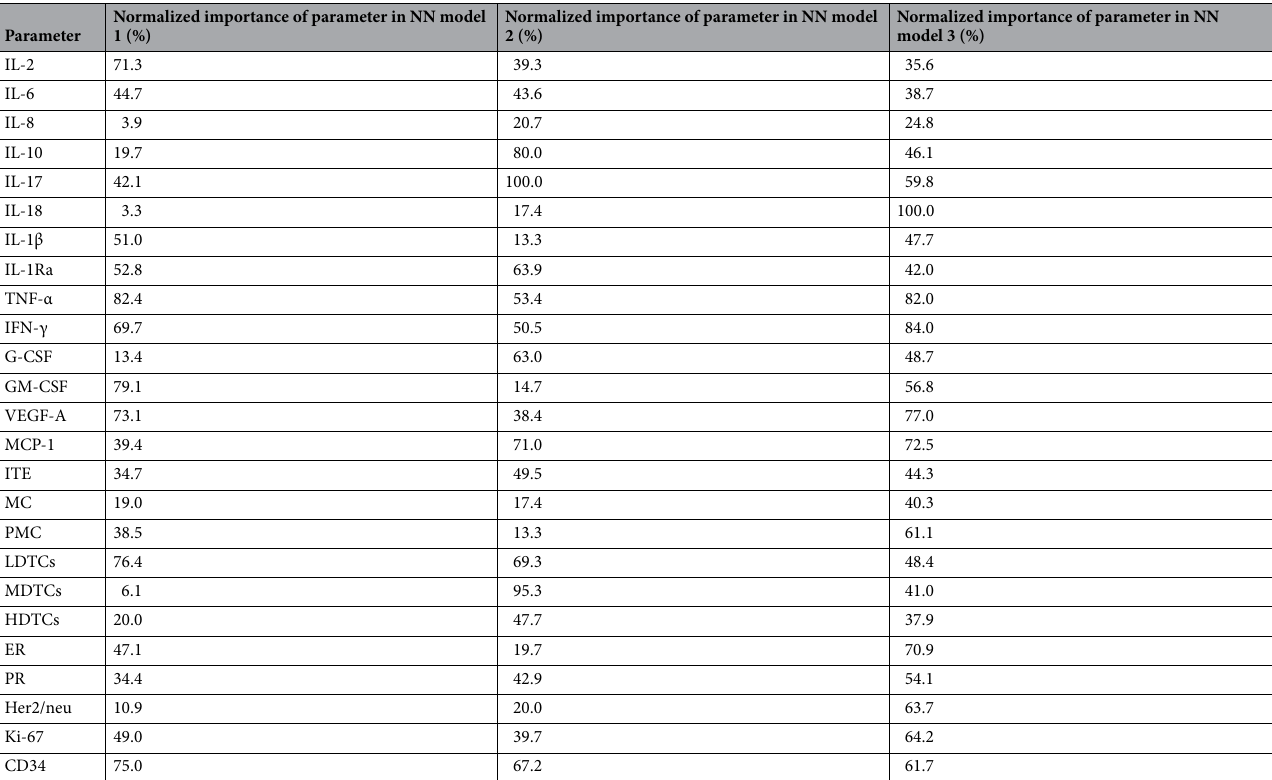
Table 1. The importance (%) of IC-NST parameters according to three neural network (NN) models for the detection of presence or absence of metastasis to RLNs. The neural network (NN) models are based on a